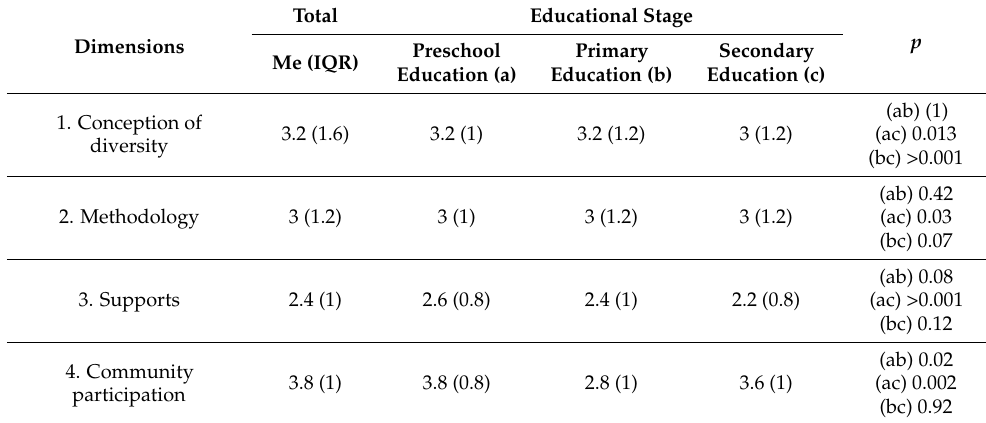
Table 3. CEFI-R dimensions descriptive analysis and differences considering educational stage.